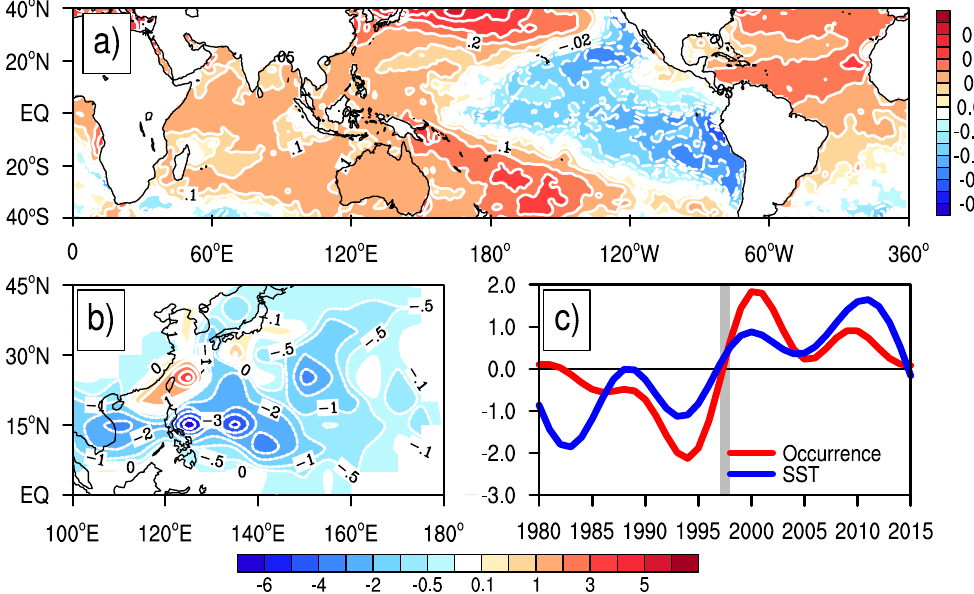
Figure 3. Spatial and temporal structures of the first EOF modes of global SST anomalies and ITCTs over the Northwest Pacific. ( a , b ) The spatial patterns for the first EOF modes of ( a ) the global SST anomalies and ( b ) ITCTs over the Northwest Pacific with the corresponding interannual variabilities removed, and ( c ) the time series of their principal components with red for ITCTs and blue for SST. This figure was generated by